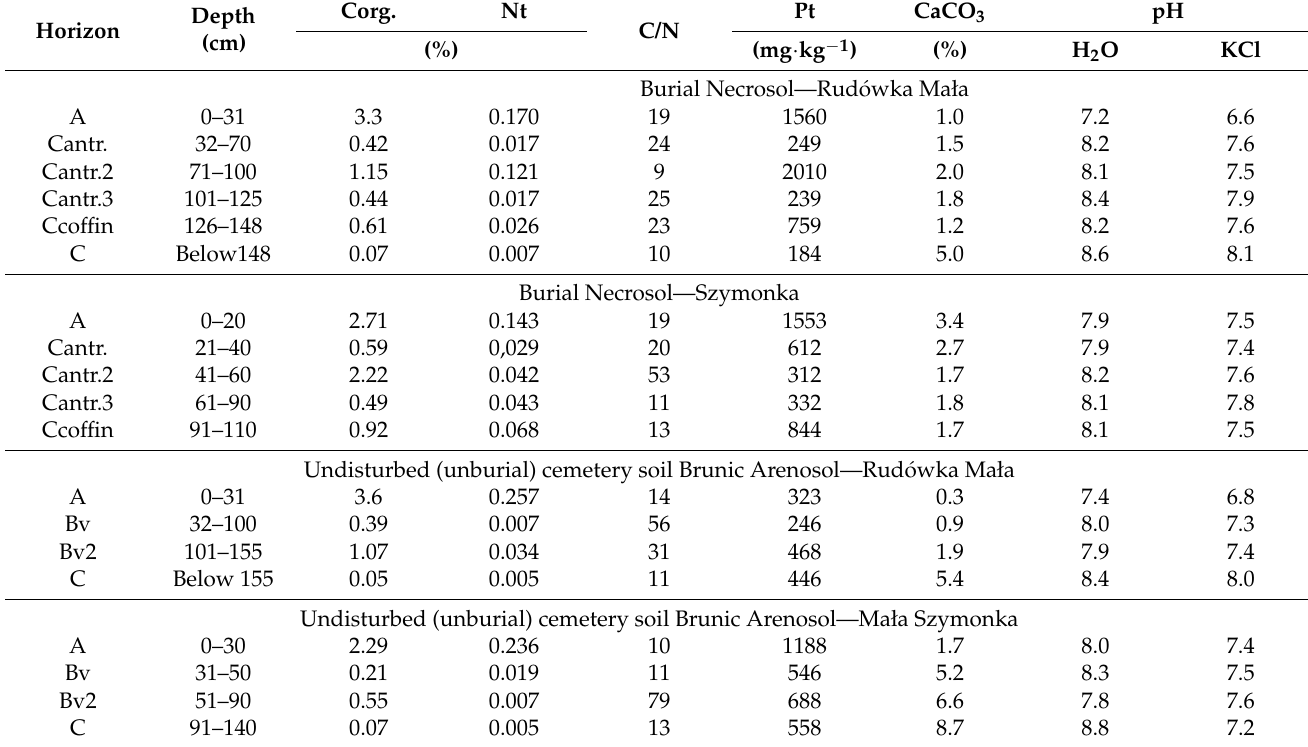
Table 2. Physicochemical properties of the burial necrosol and Brunic Arenosol